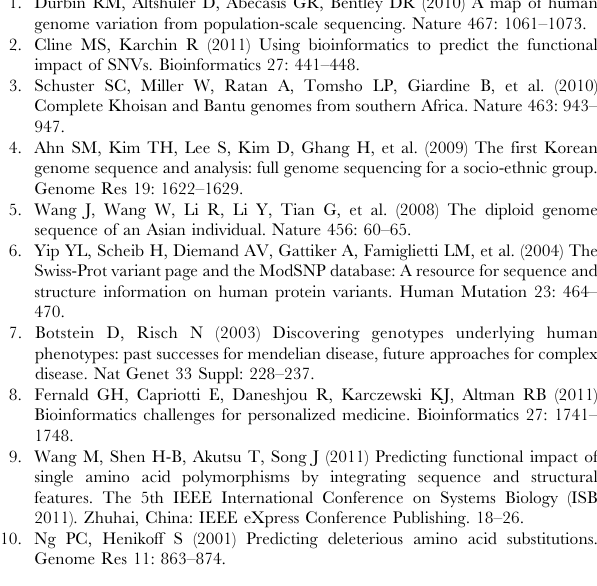
Table S1 All initial 1804 features used in this study. ‘‘OFC’’ indicate that such feature was selected as the 65 optimal feature candidates (OFCs), while ‘‘FINAL’’ indicates that such